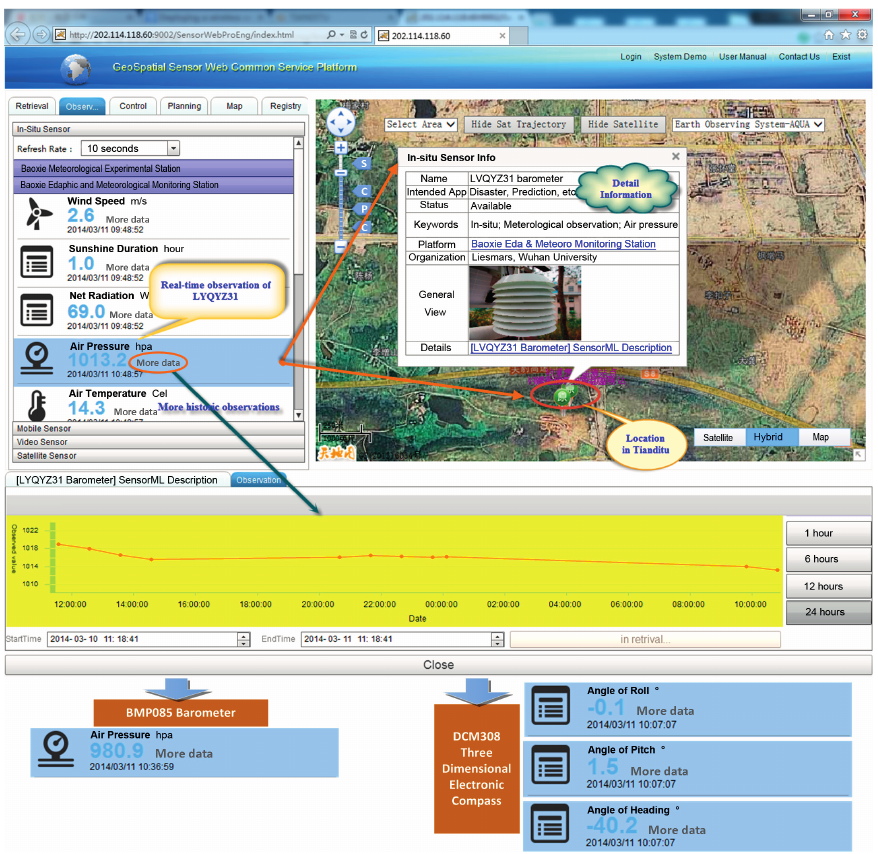
Figure 8. Geospatial Sensor Web Common Service Platform displaying location-based instant sensor